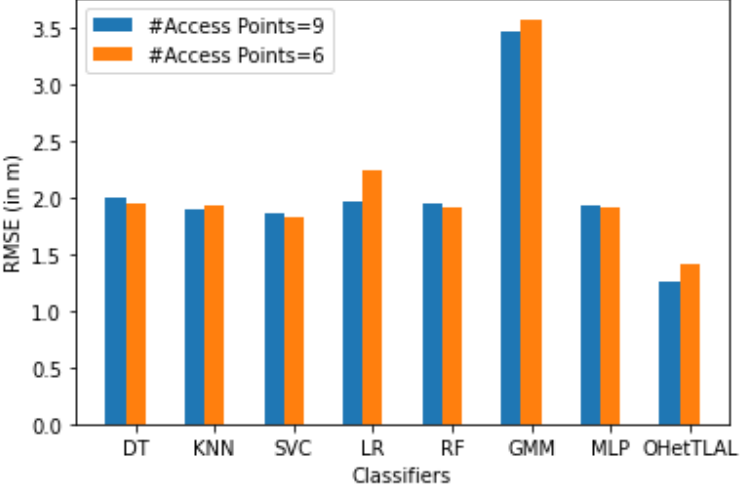
Figure 23. Effect of different feature spaces used to train classifiers for dataset B.